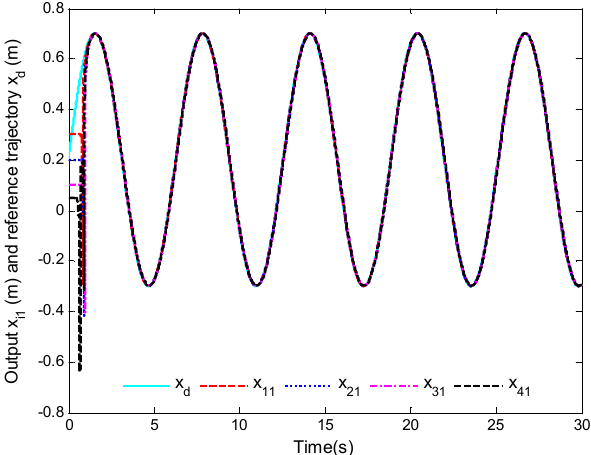
Figure 10. The curves of output x i 1 and the reference trajectory x d .